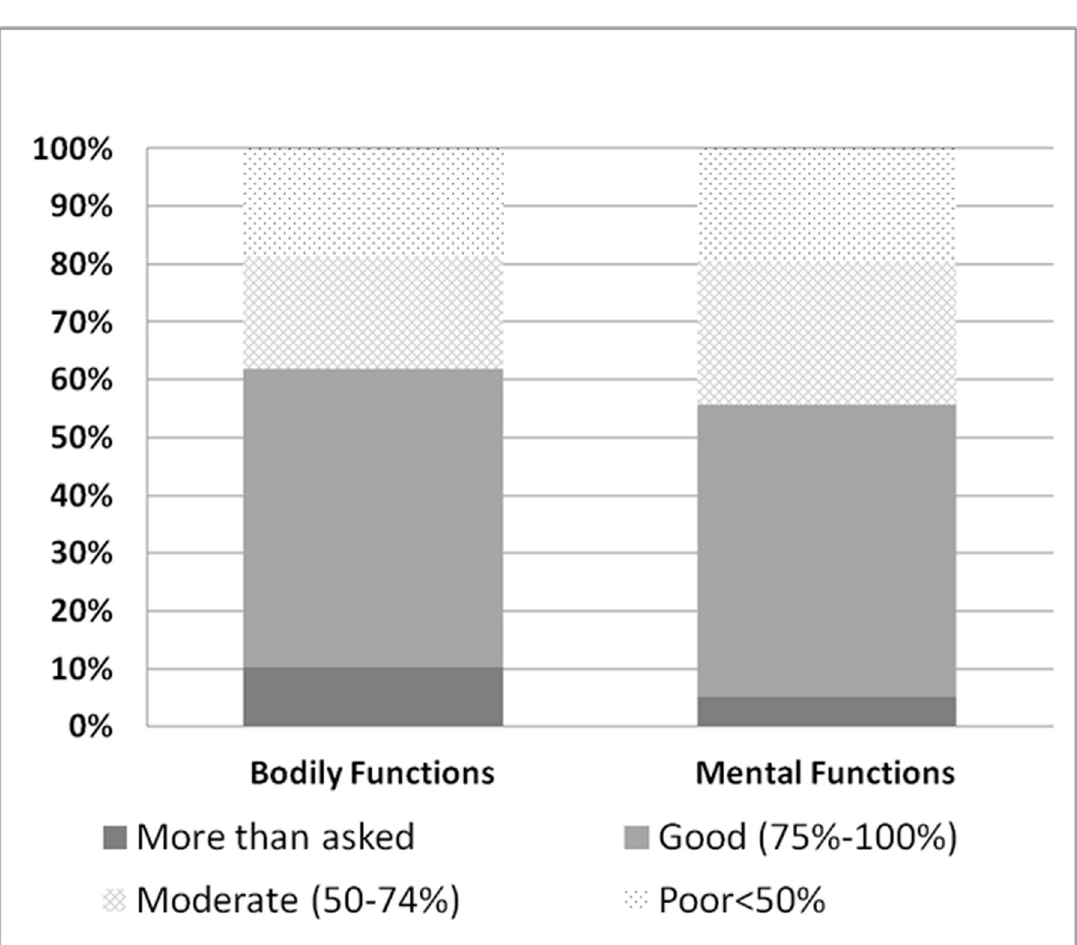
Fig 3. Adherence to PROs collection by means of the e-diary. Patients were asked to submit a bodily function report and a mental function report at least once a month. 80% of participants submitted at least 50% of the required PROs reports, while about 60% of participants submitted at least 75% of the required surveys. The adherence to bodily function reporting was slightly higher compared to the adherence to the mental function